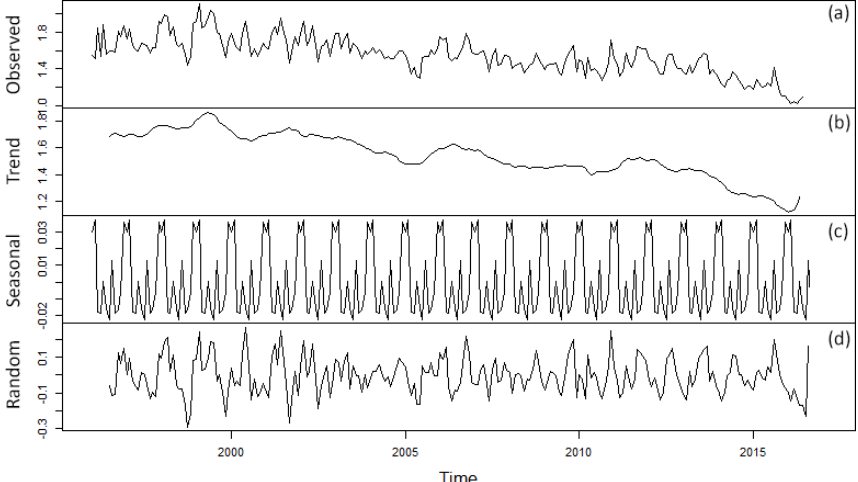
Figure 2. Time series decomposition of TGM (monthly averages) measured at Mace Head from 1996 to February 2018. From top to bottom are presented the monthly time series followed by the patterns of deconstructed components, trend, seasonality, and radon. ∗ TGM in ngm − 3